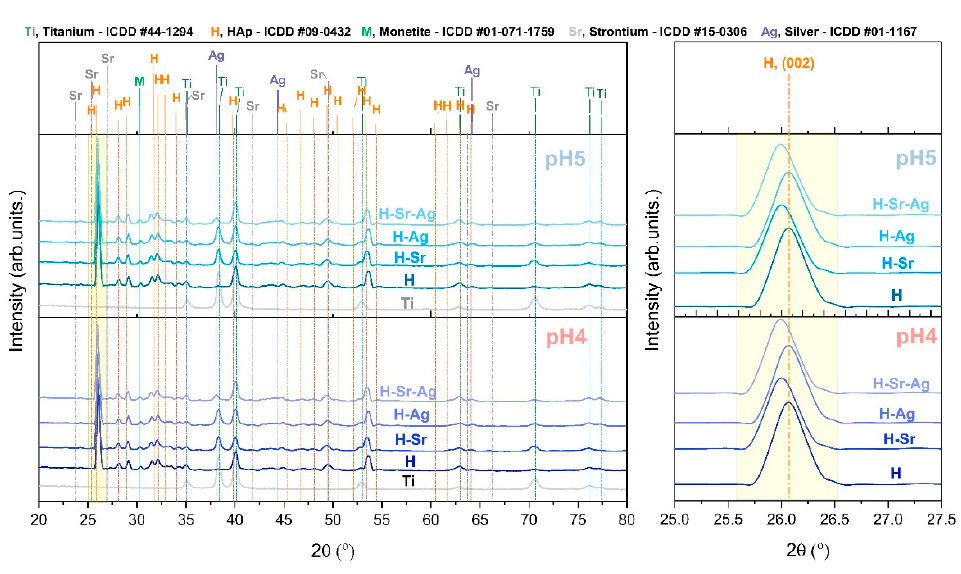
Figure 3. Evolution of (Ca + M)/P ratio ( a ) and doping element concentration (Ag, Sr and Ag & Sr) in each coating expressed in at.% and wt.%( b ).